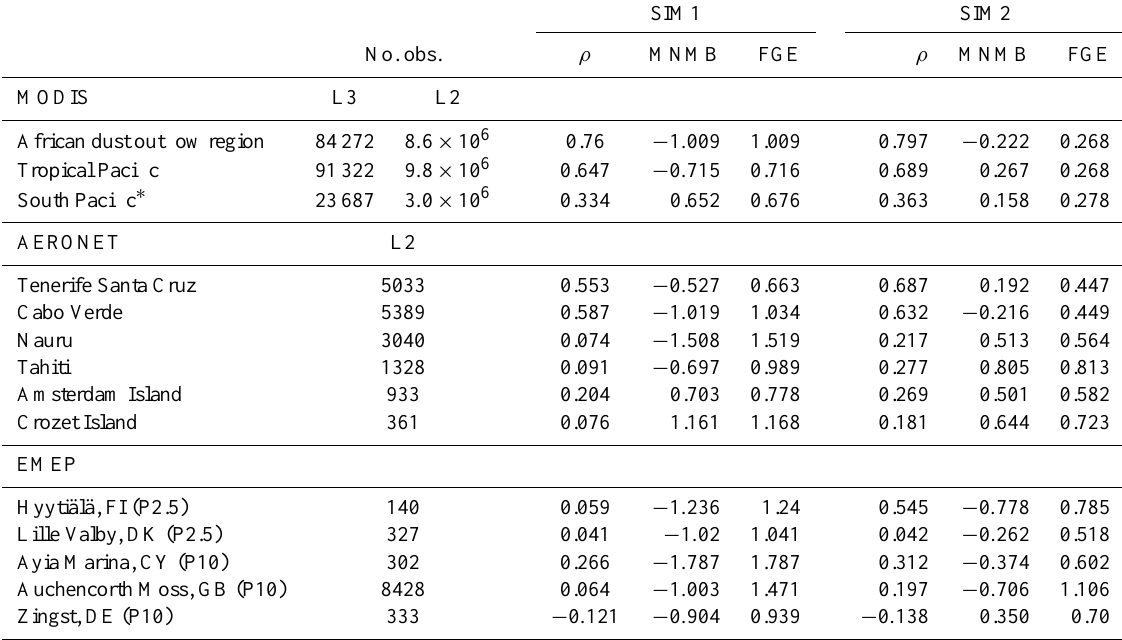
Table 3. Number of observations, correlation ( ρ ), modified normalized mean bias (MNMB) and fractional gross error (FGE) between obser- vations (MODIS and AERONET) and SIM1/SIM2. The number of MODIS observations includes the number of considered L3 gridboxes, and the corresponding number of L2 observations. EMEP observations are of hourly or daily frequency. MODIS regions correspond to Fig. 6a–c, and AERONET sites correspond to Fig. 7a–f. SIM1 SIM2 No. obs. ρ MNMB FGE MNMB